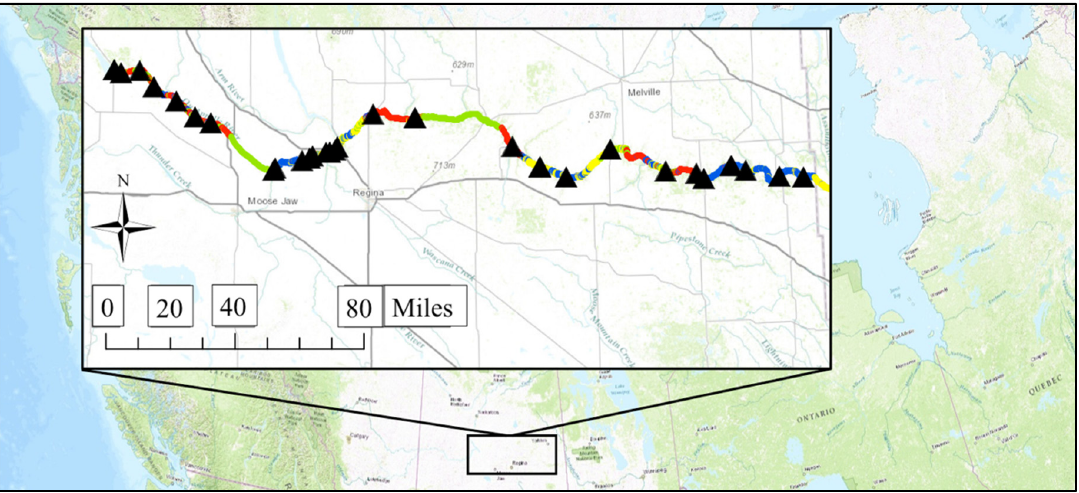
Figure 1. Location of the Qu’Appelle River in Saskatchewan, Canada. The 35 macroinvertebrate sampling sites are denoted by a triangle shape. The centerline of the river is made up of the colour coded geospatial typologies as described further in Chaper 2.2.